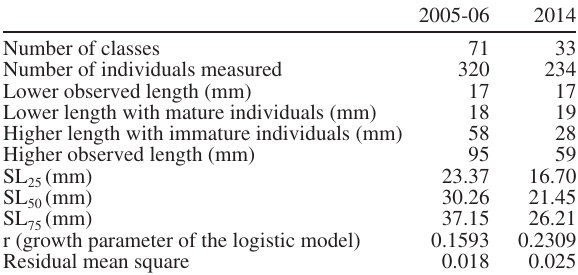
Fig. 3. – Relationship between the percentage (%) of ripe individu- als in the population and the water temperature (ºC). Table 2. – Basic sample statistics and fitting values of the logistic Fig. 5. – Scanning electron microscope image of a male gonad sec- ) for both sampling model to estimate the size at first maturity (SL tion. Acr, acrosome; fl, flagellum; mit, mitochondria. Scale bars 50 periods (years 2005-2006 and 2014). shown in image.